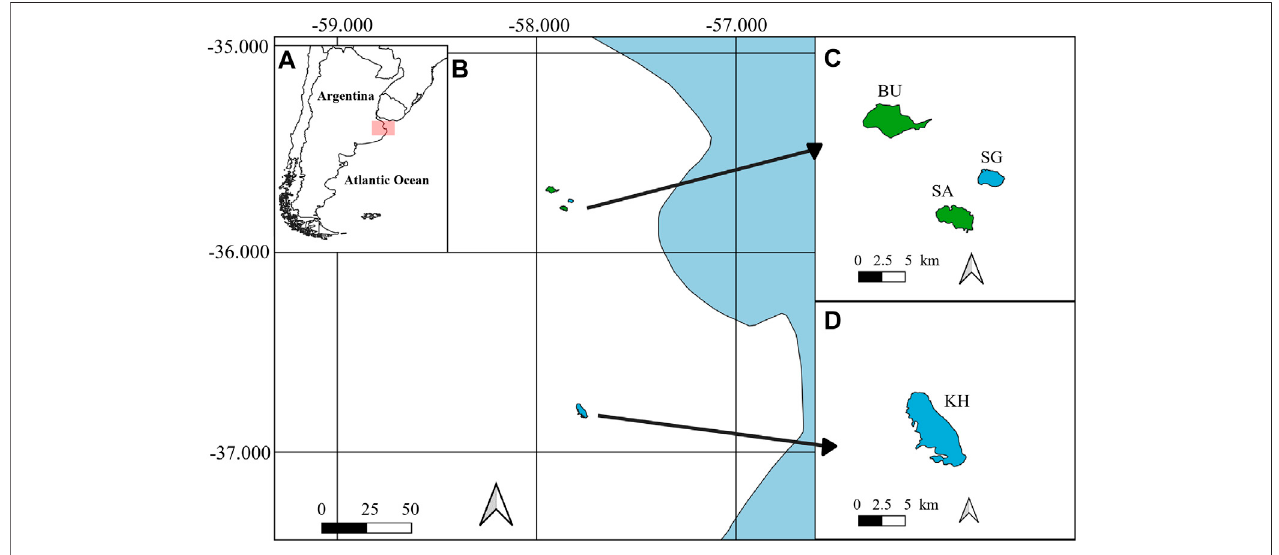
FIGURE1|(A) MapofArgentina,inredthestudyarea. (B) Studyareaandthefourstudiedshallowlakes. (C) LaSegunda(SG),LaSaladaMonasterio(SA),ElBurro (BU) and (D) Kakel Huincul (KH). Lakes in green correspond to the turbid algal lakes, whereas lakes in blue correspond to the clear vegetated lakes.